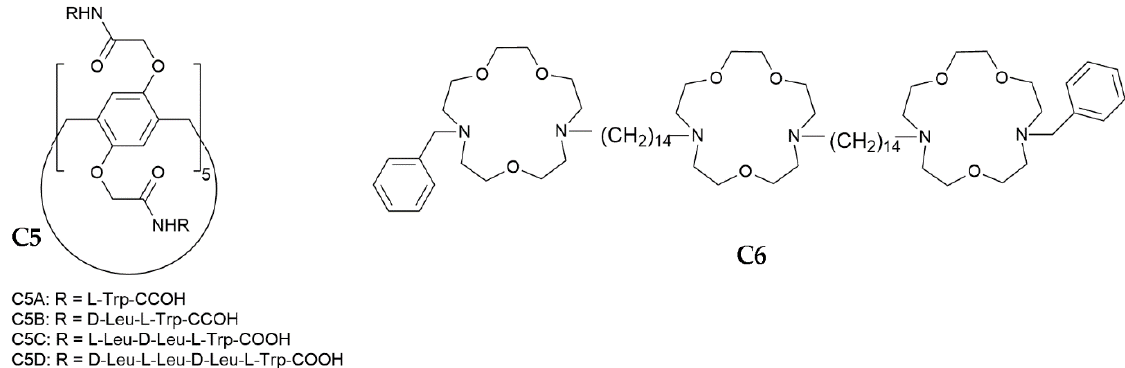
Table 3. Artificial ion transporters that were recently developed as anticancer agents. T1–T10 are selective for Cl − transport, while T11 and T12 for K +